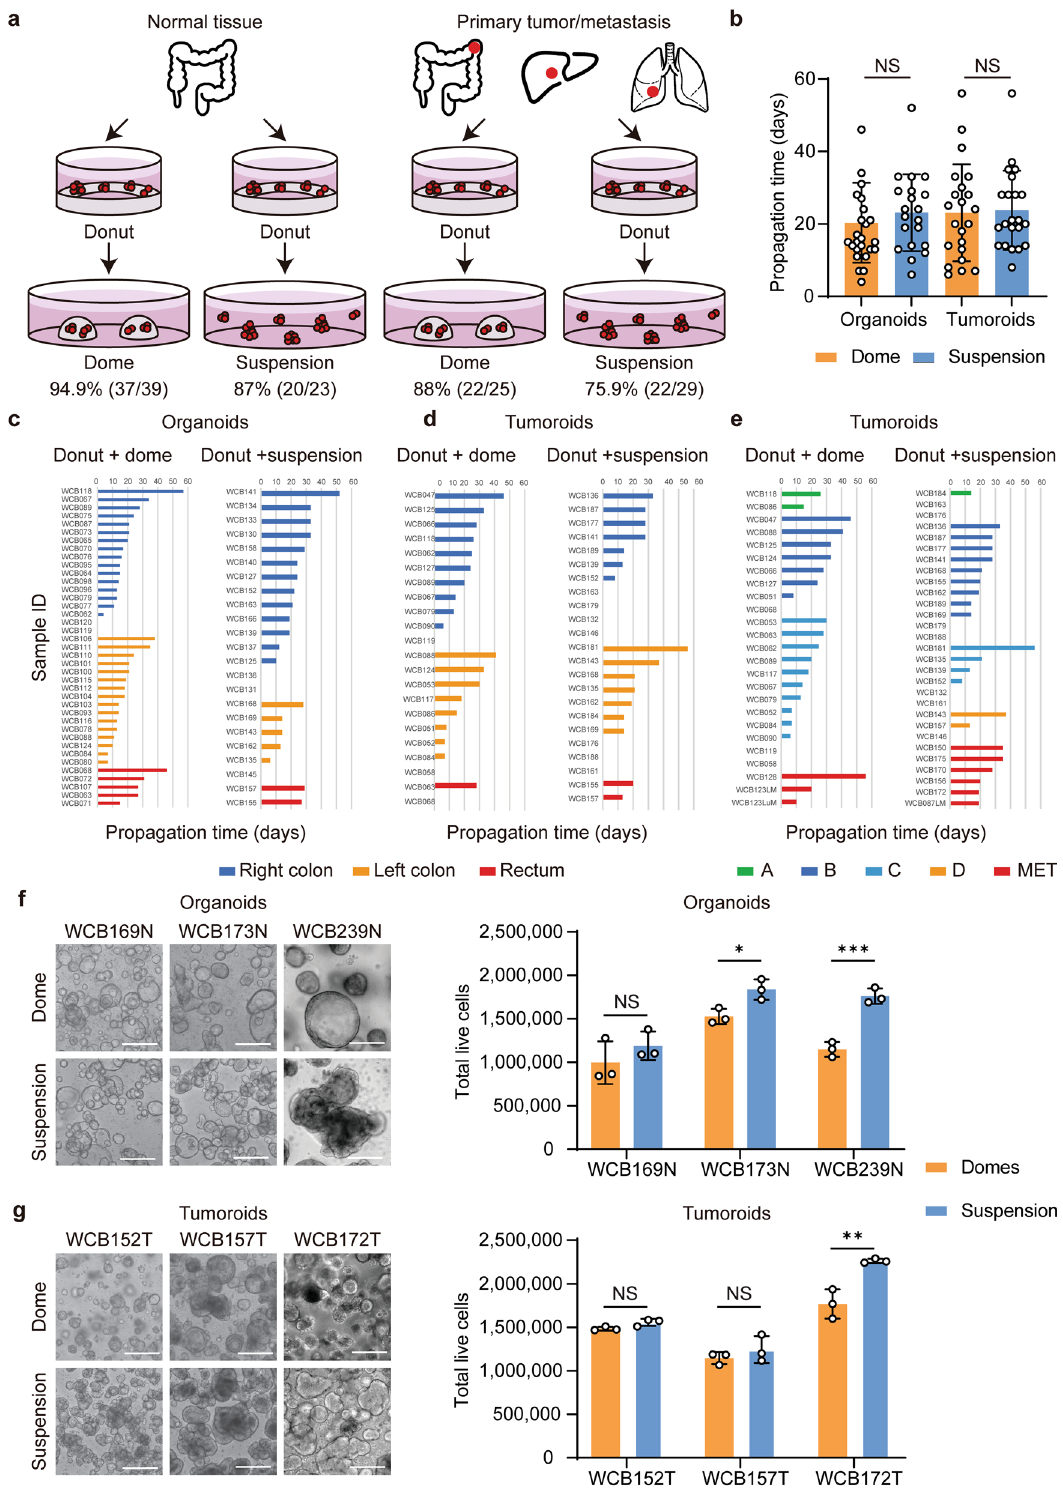
Fig. 2 Propagation of colorectal organoids and tumoroids in low-viscosity matrix suspension culture. a – b Comparison of ( a ) propagation rates and ( b ) times (passage 1 to 2) between LVM suspension and dome culture methods for organoids ( n = 23 and n = 39, respectively) and tumoroids ( n = 29 and n = 25, respectively). c – e Comparison of propagation times for organoids and tumoroids grown in LVM suspension or dome culture according to ( c , d ) location and ( e ) tumor stage. f – g Comparison of live-cell yield for ( f ) organoids and ( g ) tumoroids from three patients grown for 14 days in LVM suspension or dome culture; scale bars, 200 μ m. Data ( b , f , g ) are plotted as mean ± s.d. Statistical signi fi cance ( b , f , g ) was attributed to values of p < 0.05 as determined by the Student ’ s t test. NS, p > 0.05, * p < 0.05, ** p < 0.01, *** p < 0.001. N normal, T